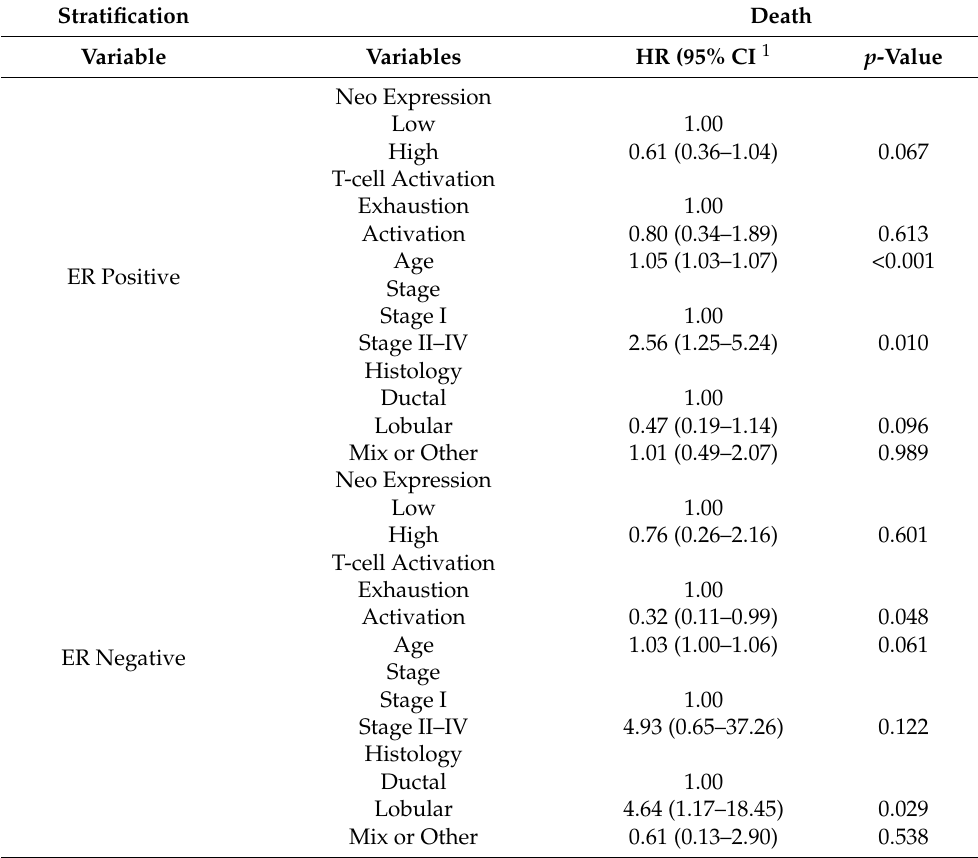
Table 4. Association between neoantigen expression and overall survival stratified by ER